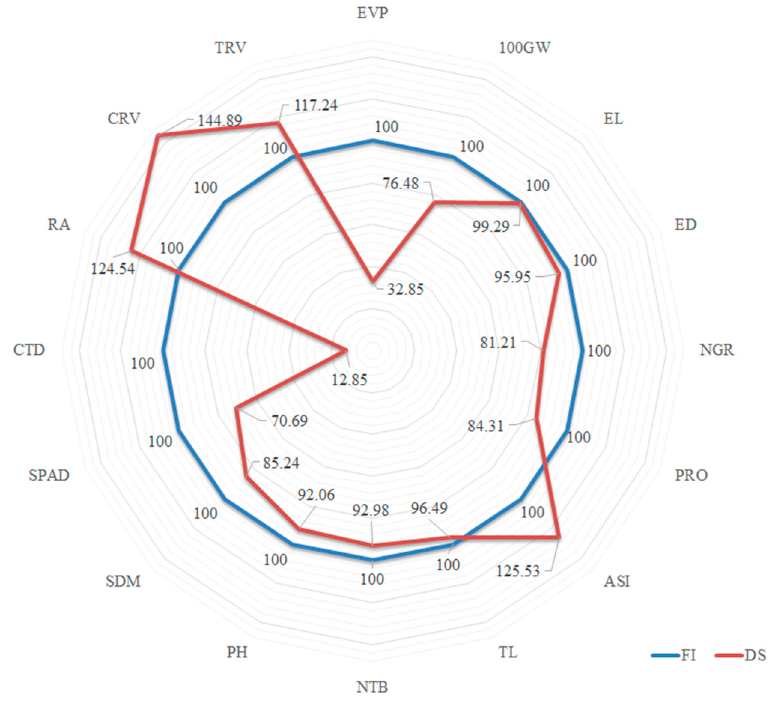
Figure 3. Relative percentages of the means evaluated in the water condition with drought stress (DS) in relation to the means without water restriction (FI), for the main variable EPV and for the agricultural, morphoagricultural, physiological and root traits, evaluated in popcorn .